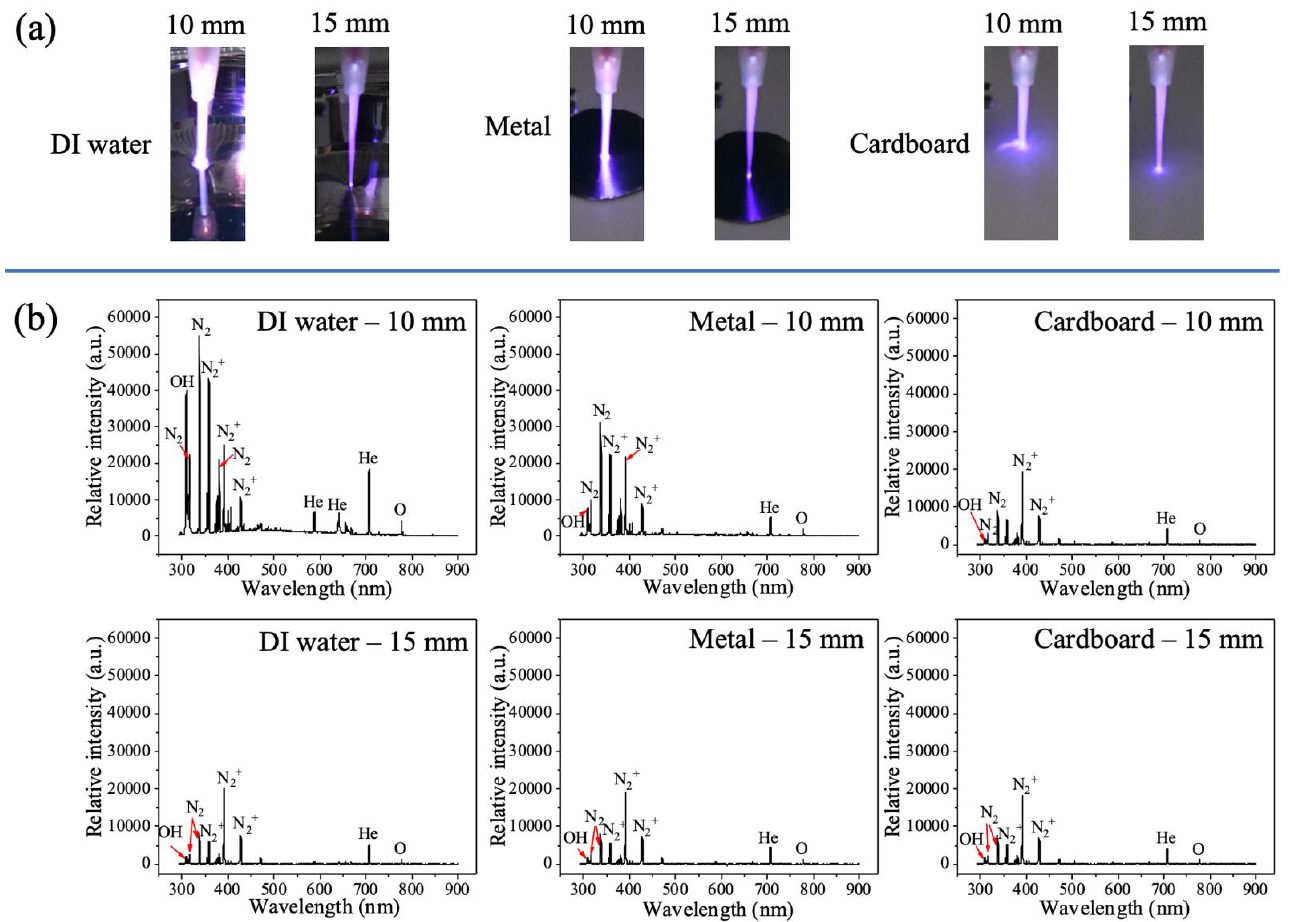
Figure 4. ( a ) Images of the tiny plasma jet interacting with deionized (DI) water, metal, and cardboard at 10 mm and 15 mm distance. ( b ) The effect of interacting processes between jets and subjects (DI water, metal, and cardboard) on optical emission spectra of tiny plasma jets.